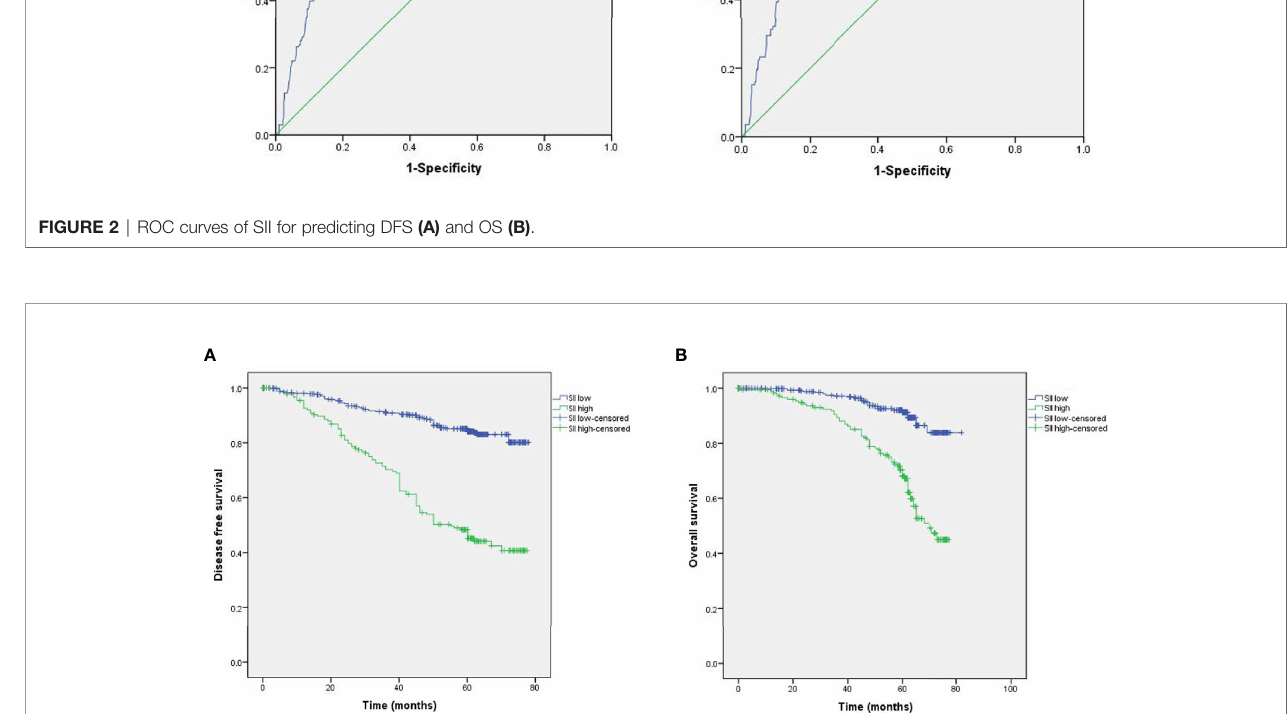
FIGURE 3 | Kaplan-Meier survival analyses of the correlation between SII and survival among breast cancer patients: DFS (A) and OS (B)